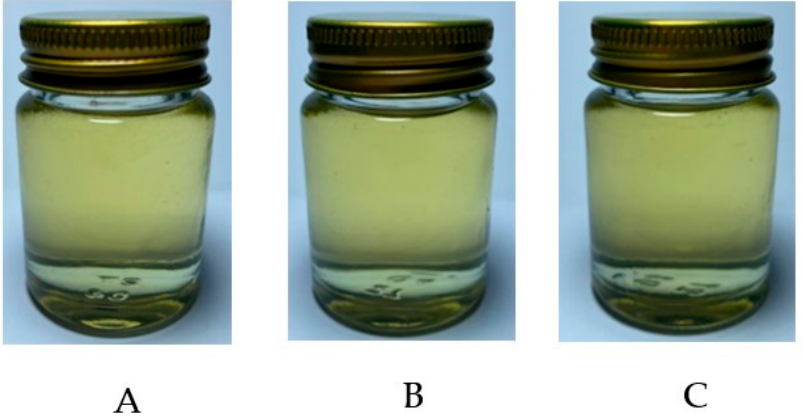
Figure 1. Appearance of ( A ) P. frutescens ( B ) M. oleifera , and ( C ) mixed seed oil microemulsions after fresh preparation. fresh